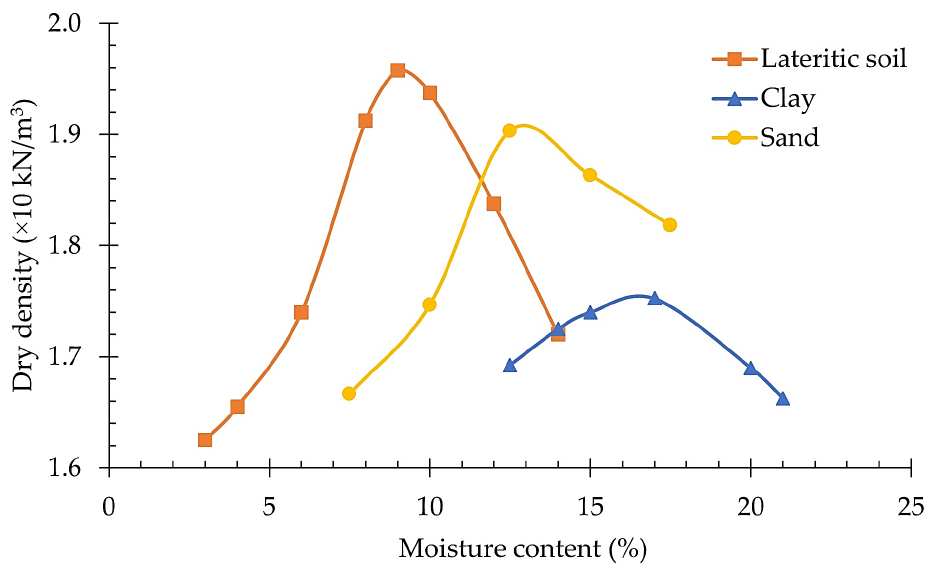
Figure 6. Compaction curve of sand, lateritic soil, and clay samples. The peak of the compaction curve shows the optimum moisture content at maximum dry density. The optimum moisture content was 12.76%, 15.77%, and 8.80% for sand, clay, and lateritic soil, respectively. These values were referred to in order to prepare and control the density of soil samples during compaction in the shear